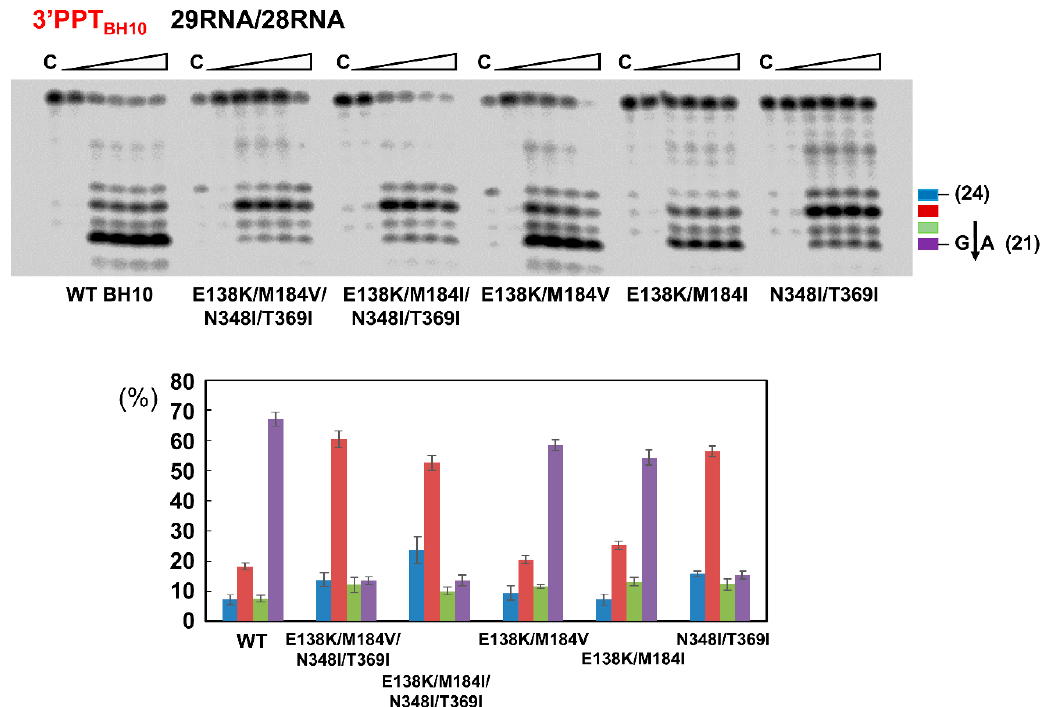
Figure 5. Effect of drug resistance mutations E138K and M184V or M184I on the RNase H cleavage window of WT and mutant N348I/T369I HIV-1 BH10 RT . Reactions were carried out in the presence of RT and template-primer 29RNA/28DNA (see Figure 4A) at concentrations of 125 nM and 25 nM, respectively. RT and 29RNA/28DNA were pre-incubated for 5 min at 37 °C, and aliquots were withdrawn at 0, 20, 40, 60 and 180 s after the addition of magnesium and heparin. Lane C shows control experiments including heparin in the pre-incubation buffer. Histograms indicate the proportions of hydrolysis products obtained from at least three independent experiments. Blue, red, green and purple bars represent the relative amounts of RNase H cleavage products of 24, 23, 22 and 21 nucleotides, respectively. The 21-nucleotide product derives from cleavage at the PPT/U3 cleavage site (indicated with an arrow in the top panel).